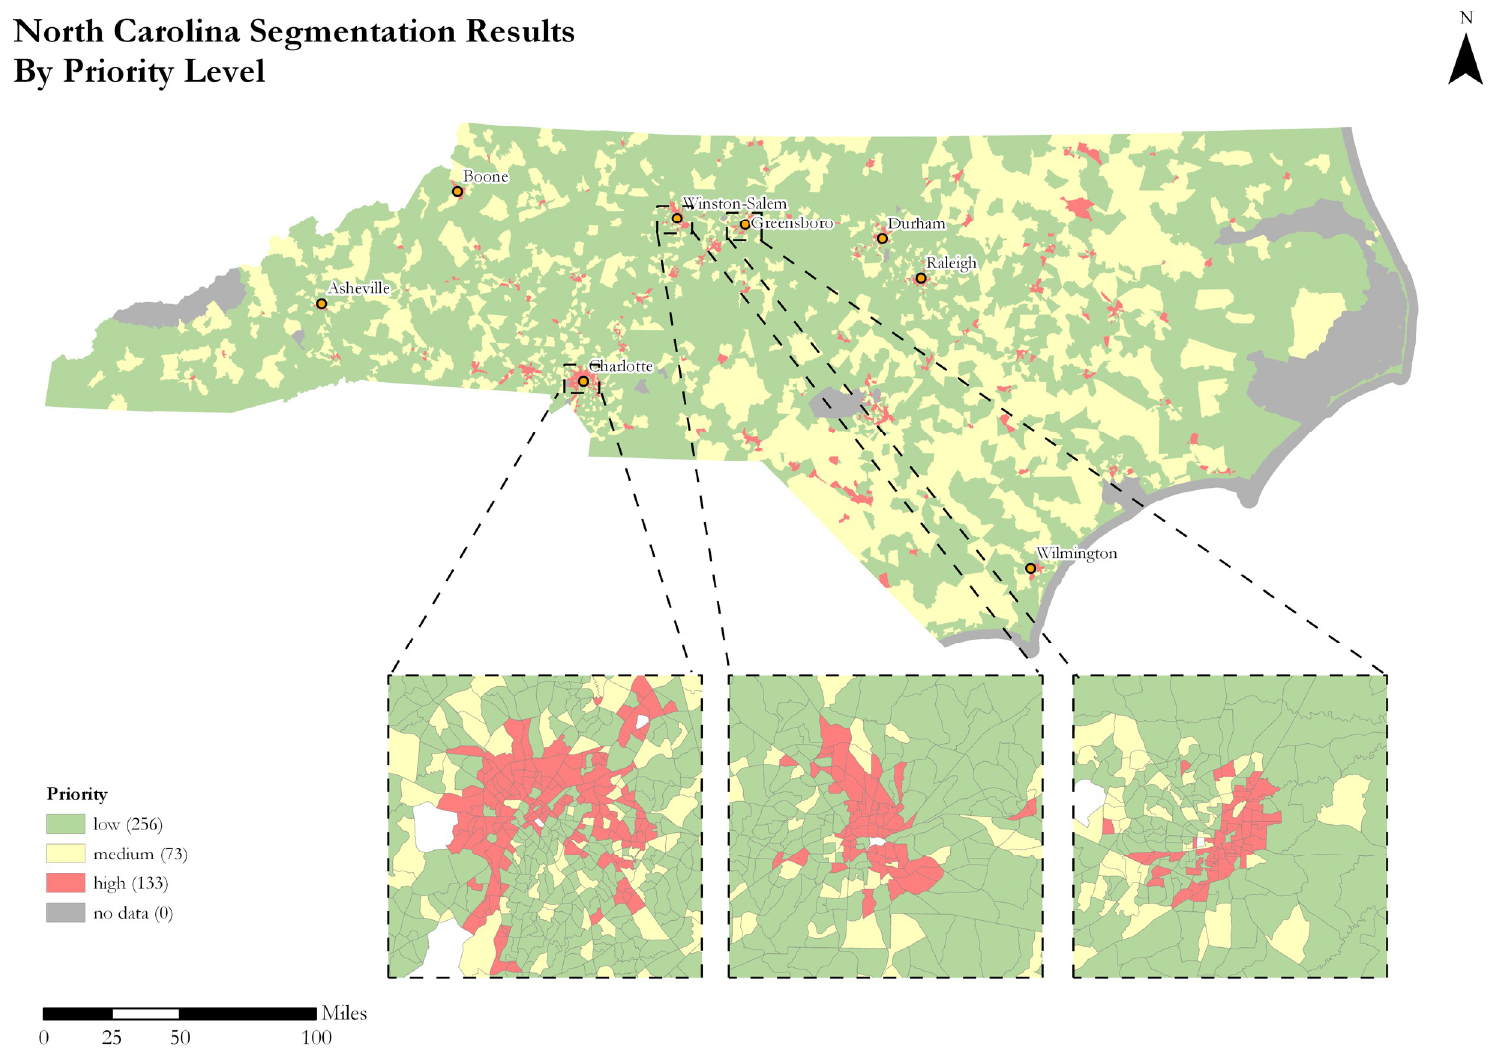
Figure 8. Geodemographic groups reclassified into low, medium, and high-priority groups.